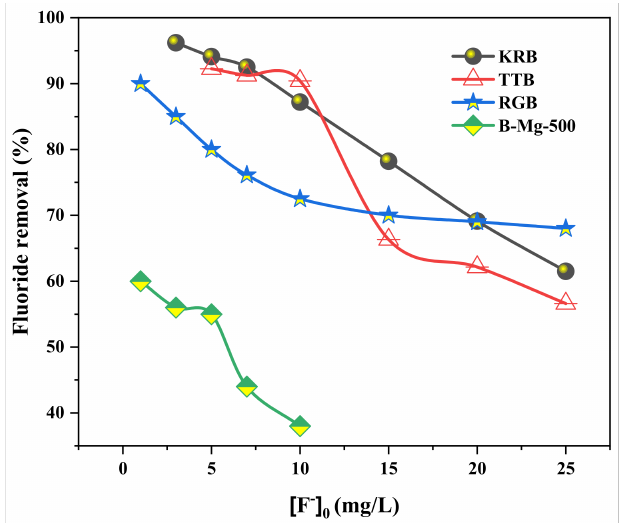
Figure 7. Impact of initial fluoride concentration on removal efficiency. Data gotten from refer- ences